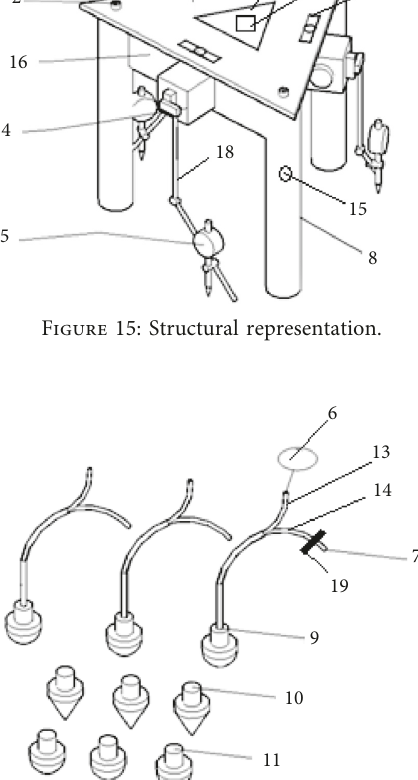
Figure 16: Schematic diagram of column feet.